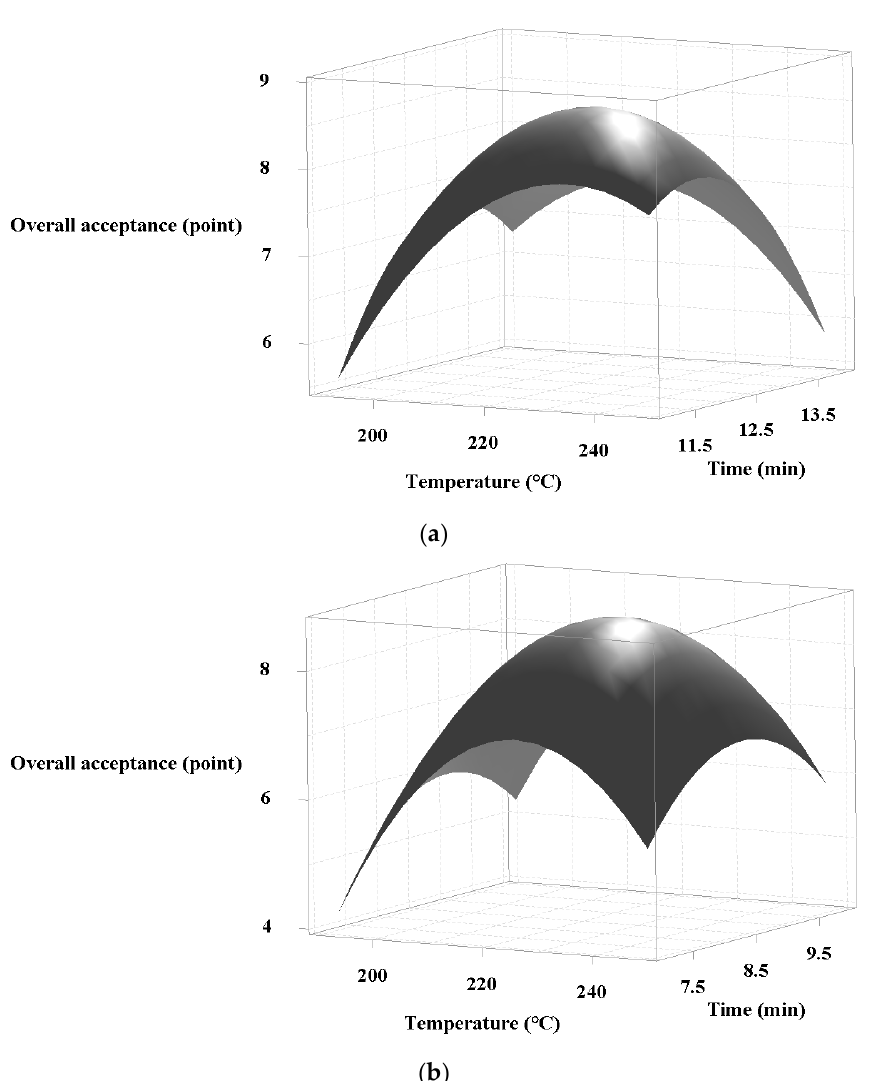
Figure 3. Three-dimensional response surface plots of superheated steam treated chicken products for overall acceptance with respect to temperature and time of roasting: ( a ) chicken leg, ( b ) chicken breast. Table 4. Optimum conditions for superheated steam-treated chicken products using response surface